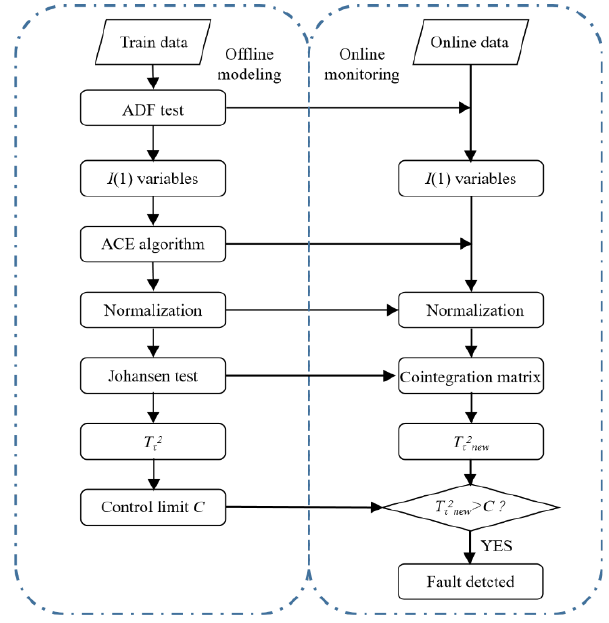
Figure 1. Monitoring strategy based on ACE and CA.